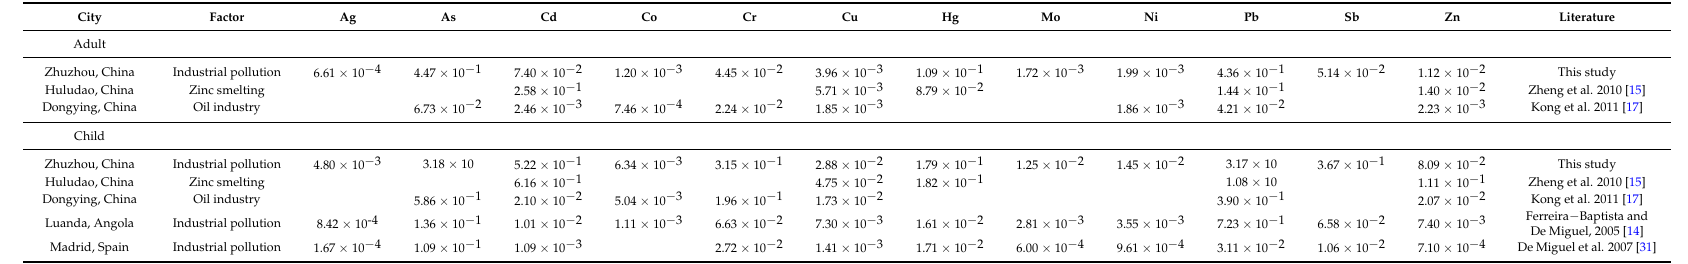
Table 6. Comparisons of hazard quotient for trace metals in urban dust of different cities.